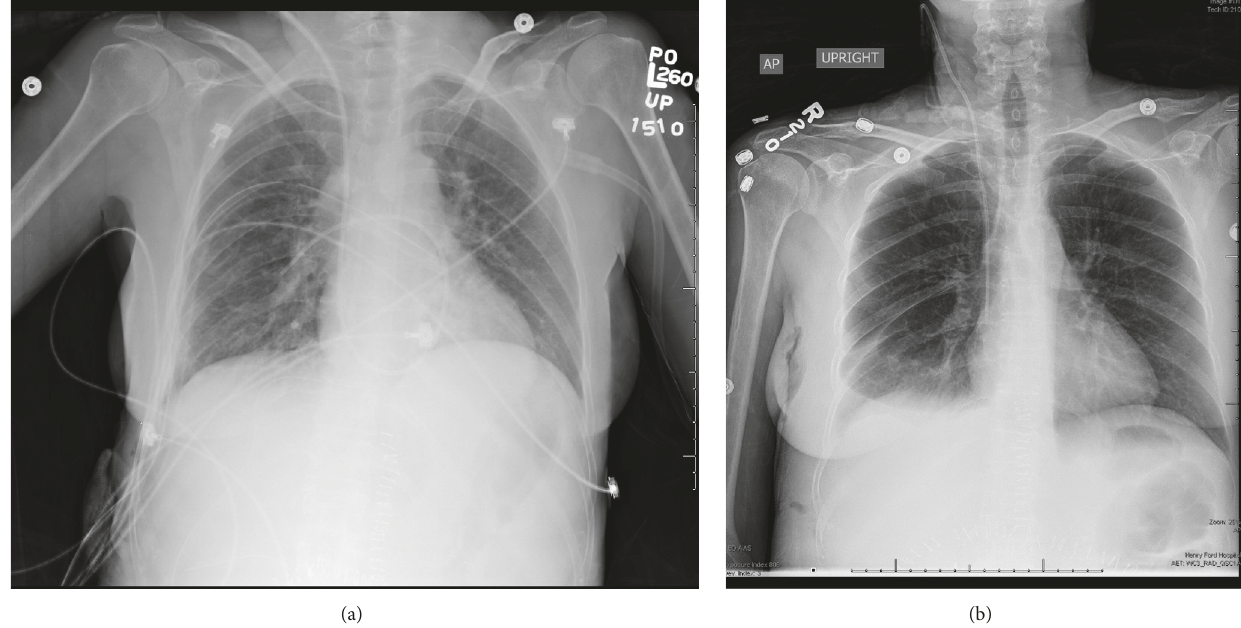
Figure 3: Chest x-rays with chest tube in situ and after removal of chest